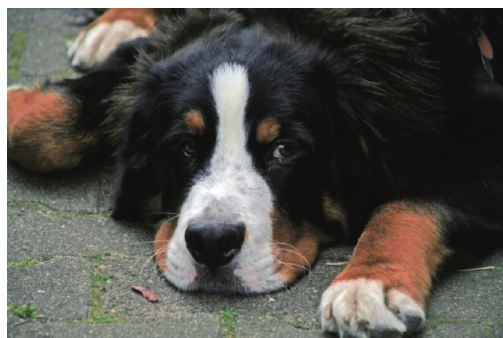
Figure 6: Temporary tarsorrhaphy to protect the empty fornix.